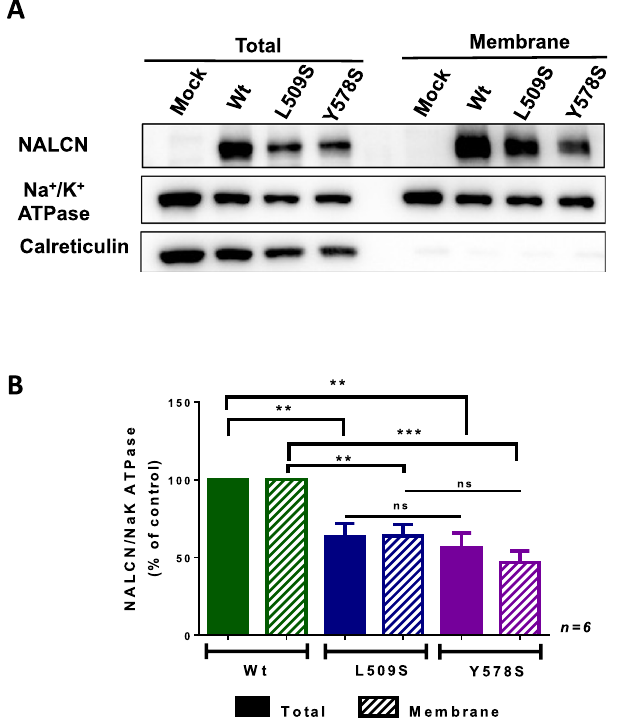
Figure 7. Total and membrane expression of wt NALCN channel and its L509S and Y578S variants. ( A ) Representative cell surface biotinylation experiment. The cell surface biotinylation assay was performed in cells transfected with NLF1 alone (Mock) or along with wt NALCN, NALCN-L509S or NALCN-Y578S (GFP tagged). The Na + /K + ATPase, a plasma membrane protein, and the calreticulin, a reticulum-resident protein, were used internal controls. ( B ) The expression levels of wt NALCN, NALCN-L509S and NALCN-Y578S were normalized with the Na + /K + ATPase level from both total and membrane fractions. The total expression compared to NALCN was: L509S, 62.99 ± 8.725%, p < 0.01; Y578S, 56.24 ± 9.408%, p < 0.01, while the membrane expression compared to NALCN was: L509S, 63.94 ± 7.261%, p < 0.01; Y578S, 46.69 ± 7.412%, p < 0.001 (n = 6 independent experiments). Statistical significance was calculated with a one-way ANOVA multiple comparisons